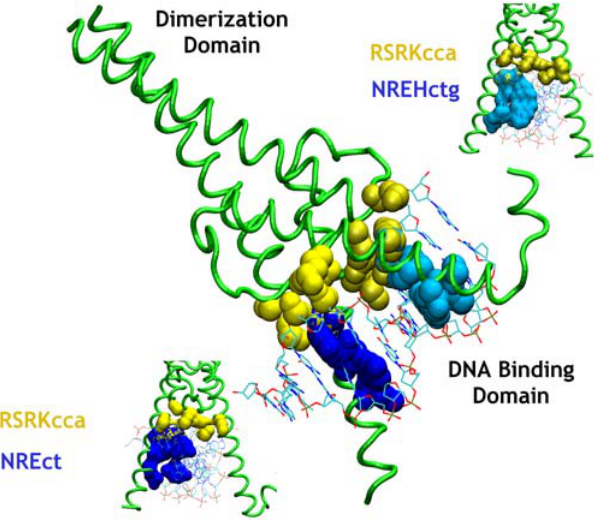
Figure 7. Interaction of the transcription factor Max (1hlo) of the zipper-type group (basic-helix-loop-helix-zipper) with DNA. The Max transcription factor, which belongs to the Helix-Loop- Helix Zipper family, has a dimerization domain and a DNA binding domain (center). The DNA binding domain shows the presence of symmetric P-p (yellow) and asymmetric P-B clusters (blue) (upper and lower). The cluster compositions are given (single letter code for nodes: upper case for amino acids and lower case for nucleotides). The cluster compositions for other proteins are given in Table S2. There is a marked absence of P-S clusters in the recognition of DNA by this zipper protein.